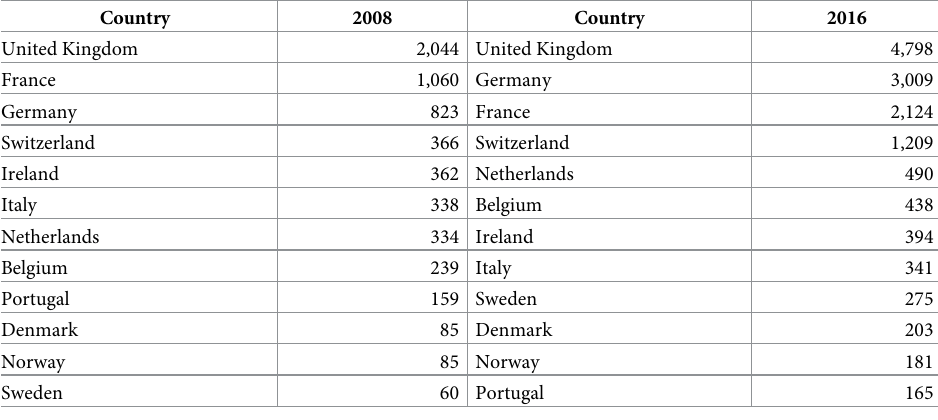
Table 2. Flow of Spanish migrants between 15 and 34 years old to foreign